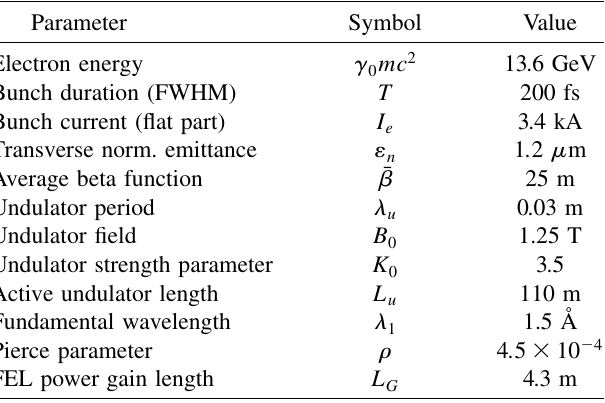
Main parameters for the LCLS FEL.